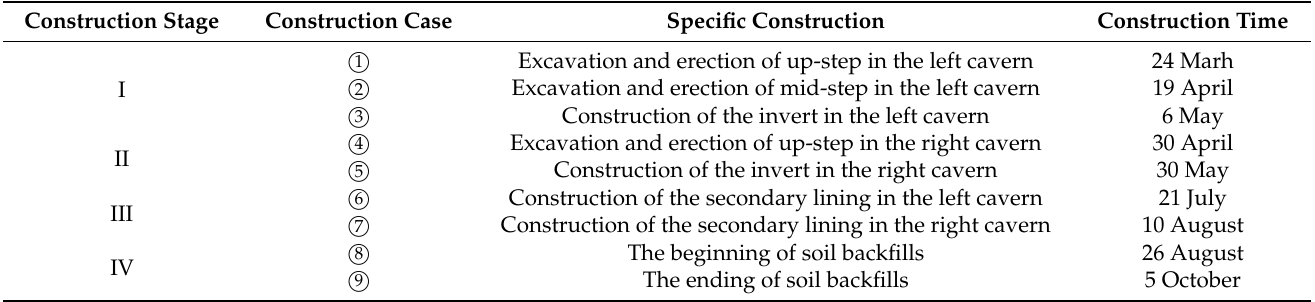
Table 4. Main construction cases and construction stages.